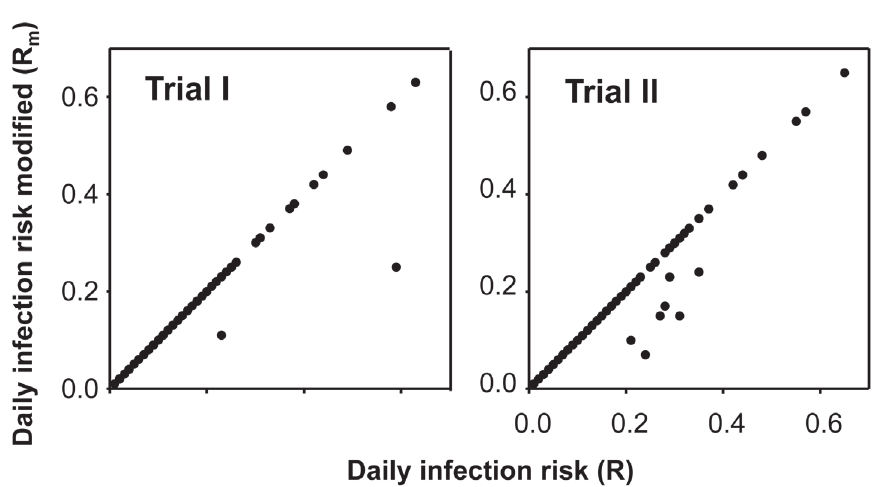
Figure 4. Comparison between daily infection risks obtained using BSPcast (R) or BSPcast-m (R